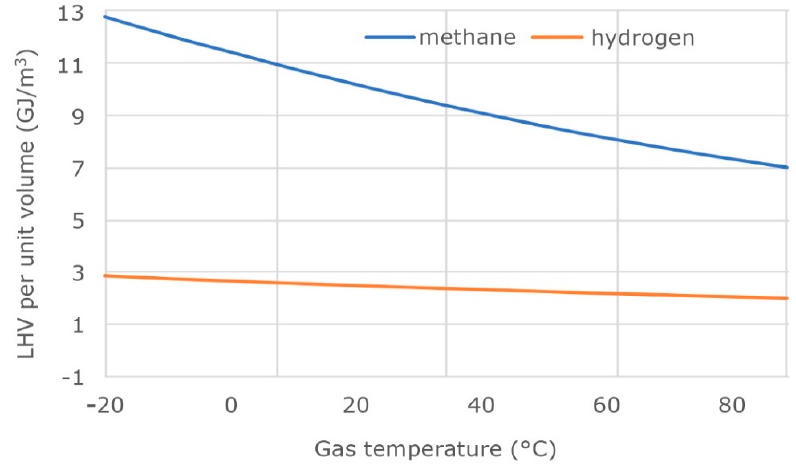
Figure 21. Energy density of CH 4 vs. H 2 .